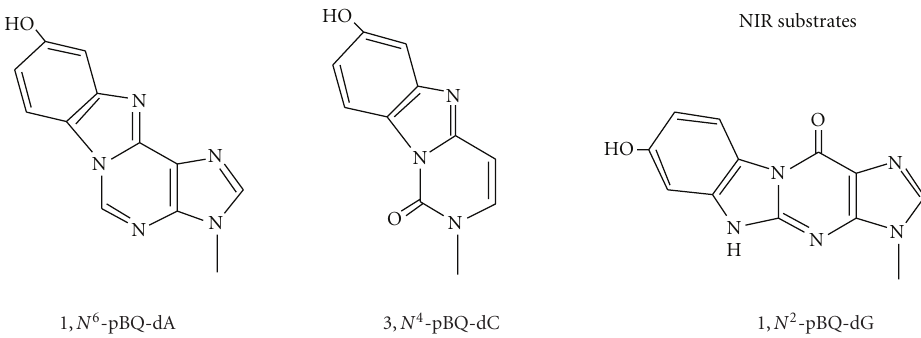
Figure 6: Structures of smoking-induced bulky DNA adducts that are substrates for